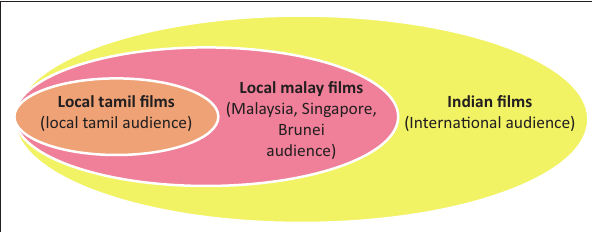
FIGURE 2: Comparison of motion picture production scale and target in